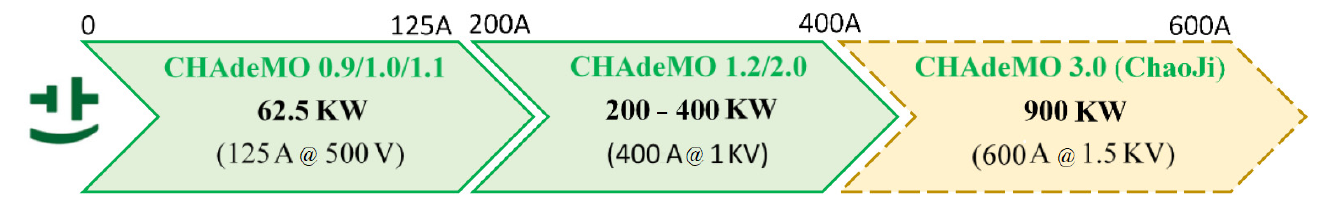
Figure 20. CHAdeMO standard specifications.